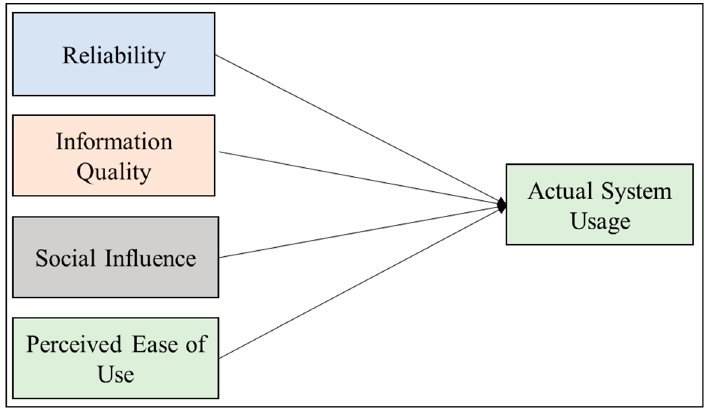
Figure 1. Cloud E-Learning SQ Model (E-LSQM).